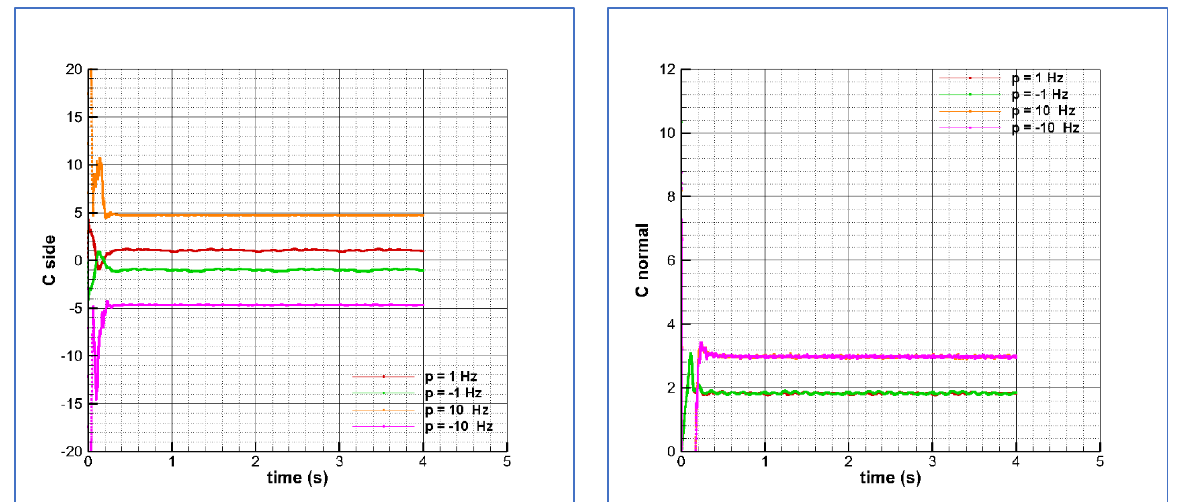
Figure 10. Side ( left ) and normal ( right ) force coefficients versus time at Ma = 0.2, Re =2 × 10 6 and α = 20 deg.